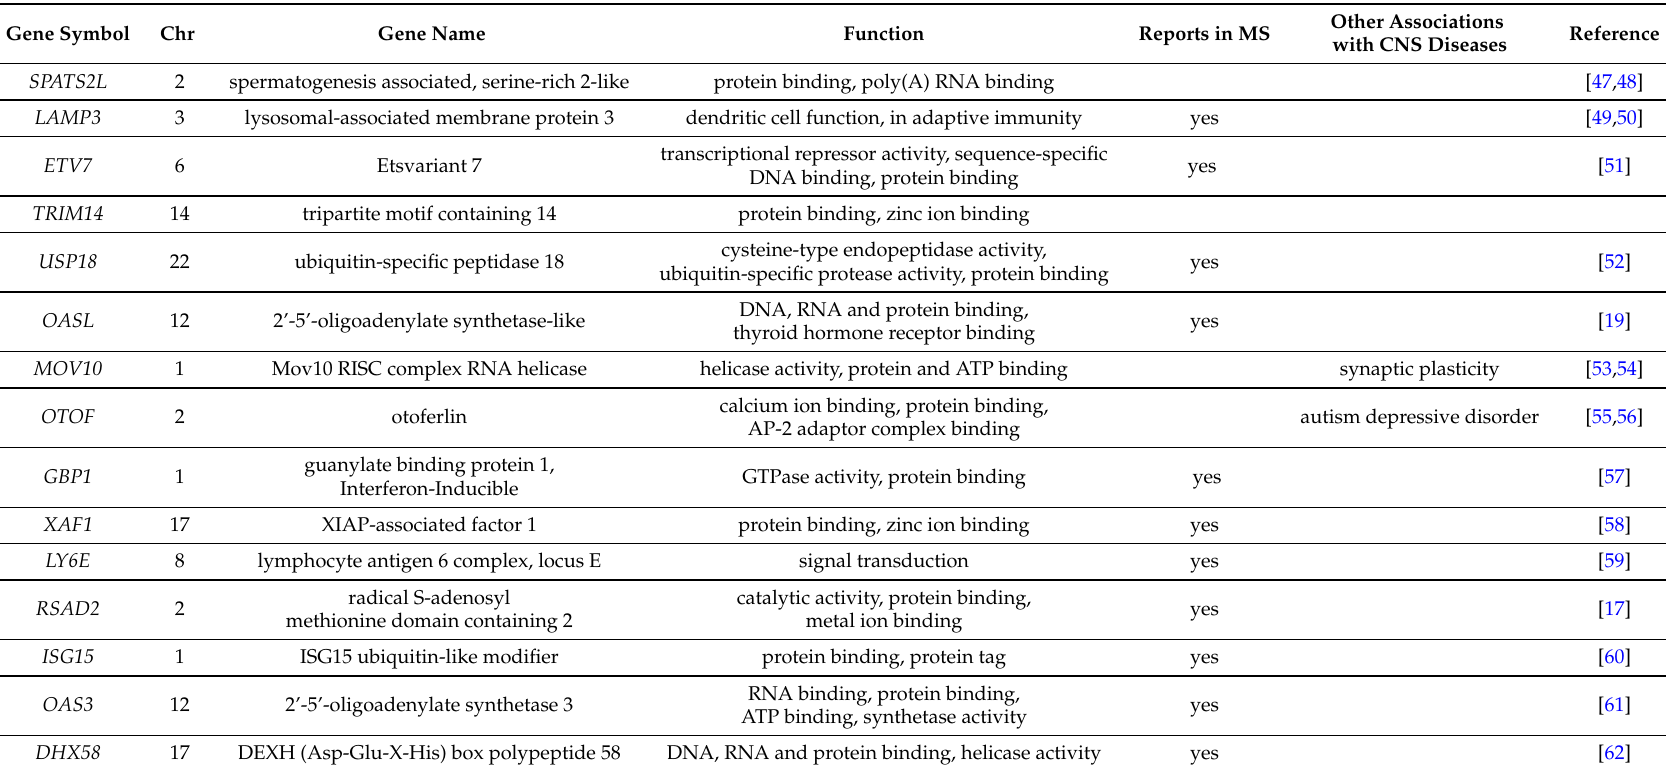
Table 5. Genes DC at the level of 0.05 in the untreated vs. IFN- β treated comparison in all 3